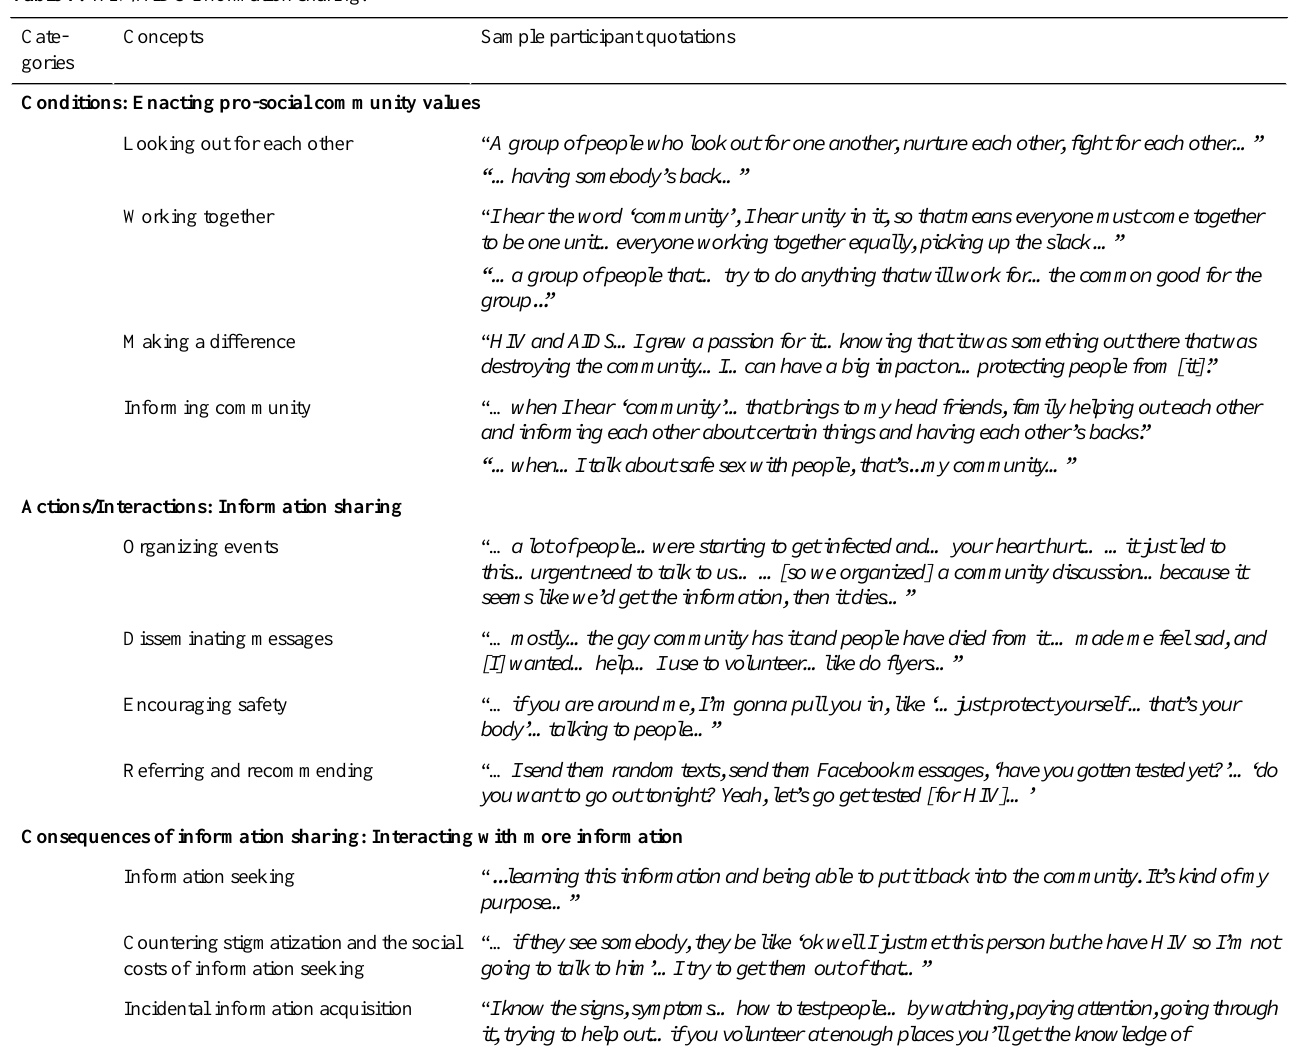
Table 7. HIV/AIDS information sharing.